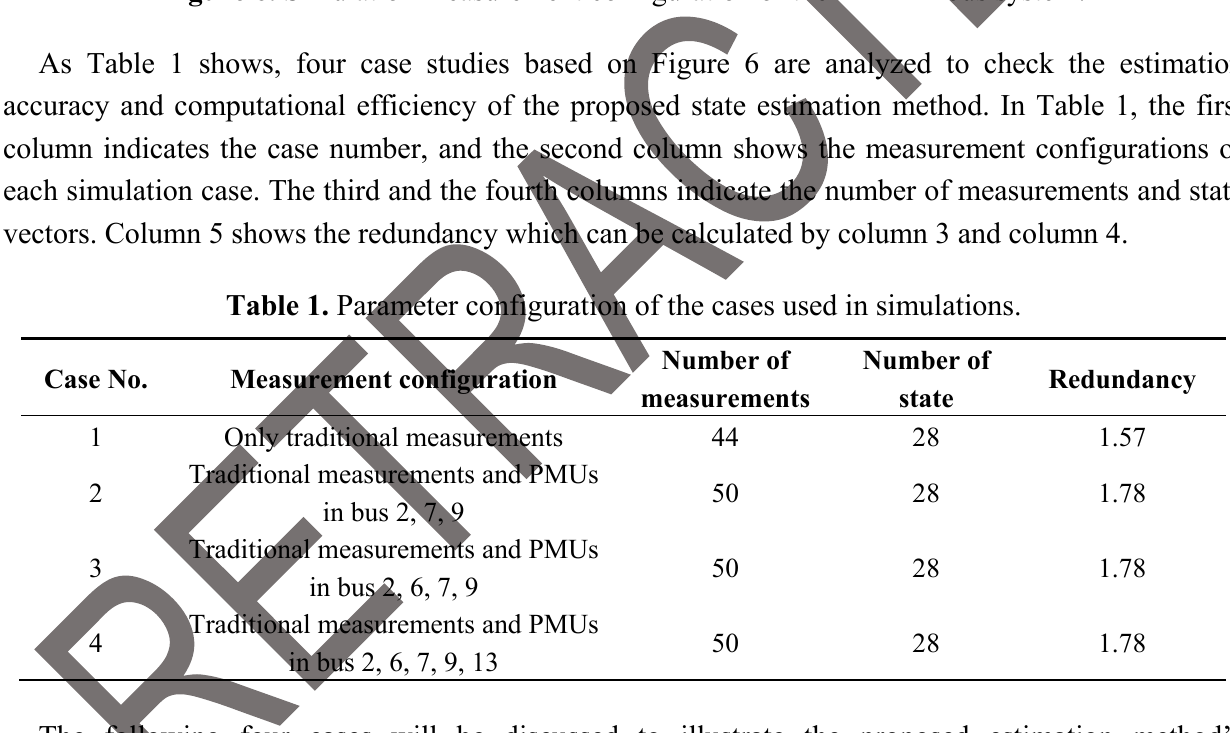
Figure 6. Simulation measurement configuration of the IEEE 14 bus system.